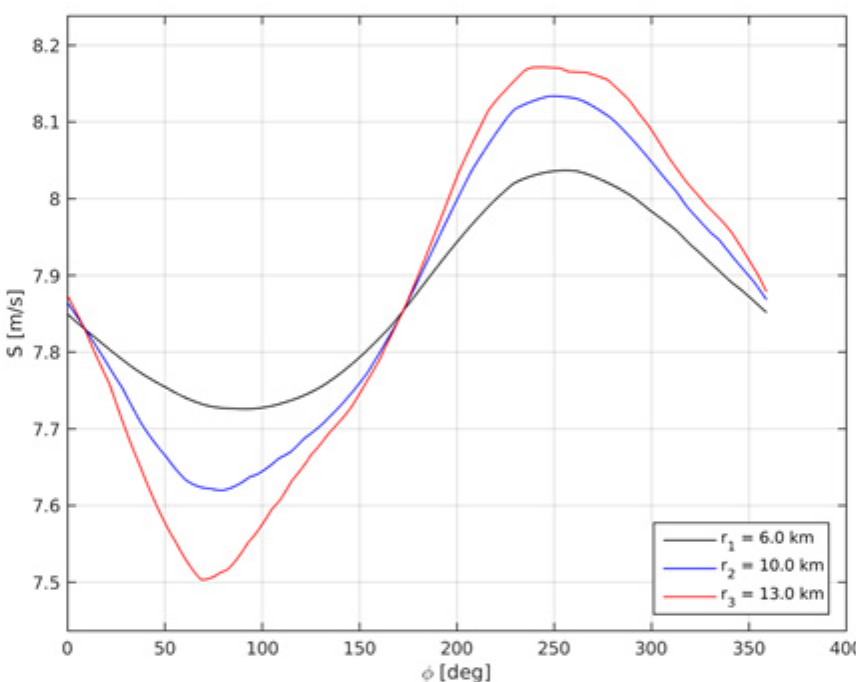
Figure 8. Horns Rev 1 wind speed summations without rotation ( S ) based on WRF without wind farms, so showing only the coastal wind speed